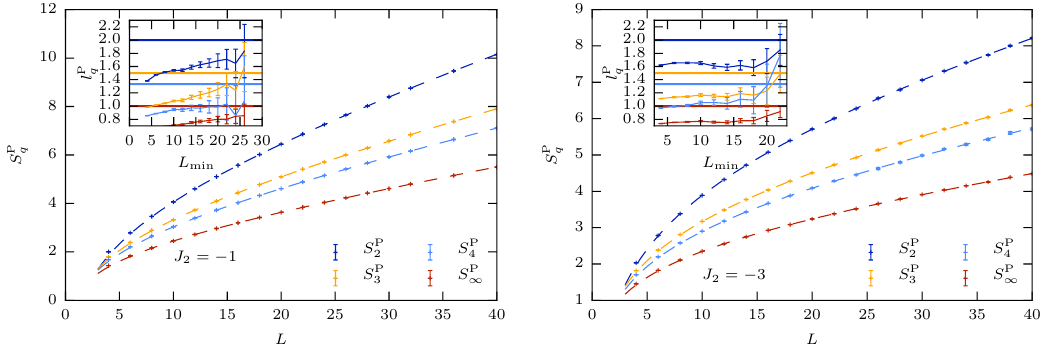
= − 1 (left) and of the line shaped subsystem A for J 2 q ,40 ] as a function of L . Horizontal lines are min min